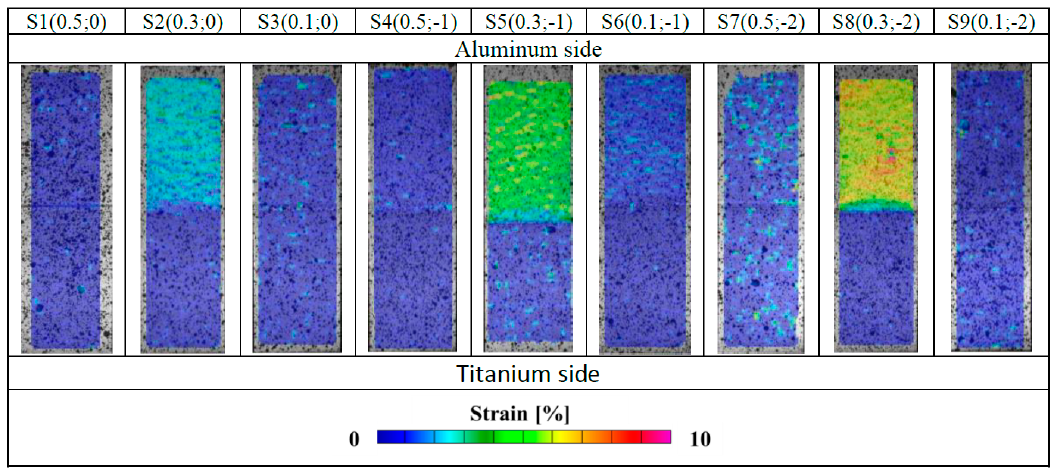
Figure 10. Deformation maps obtained by means of the DIC system (off-set; focus).